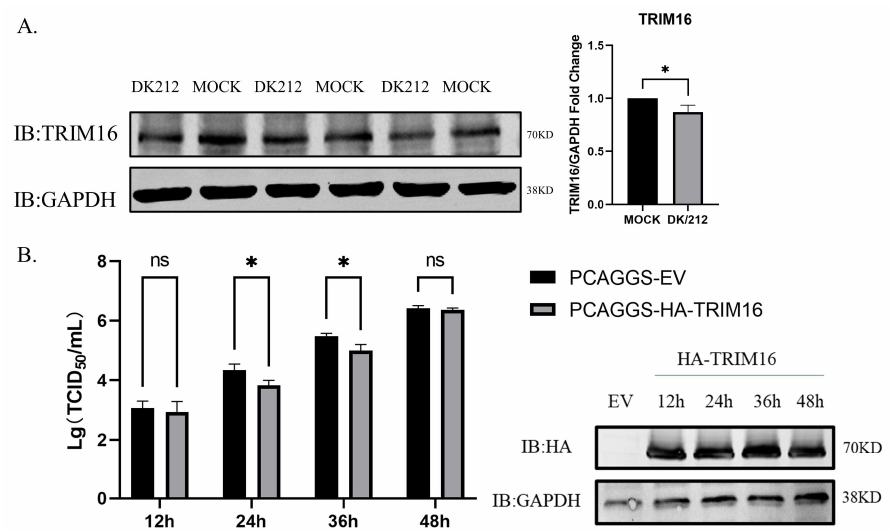
Figure 3. Overexpression of HA-TRIM16 reduces the titer of DK/212 virus in A549 cells. ( A ) Avian influenza virus infection reduces TRIM16 expression. Western blot analysis of TRIM16 protein expression in A549 cells infected with DK/212 virus for 24 h. GAPDH was used as loading control. ( B ) A549 cells were transfected with PCAGGS empty vector or PCAGGS-HA-TRIM16. At 24 h post transfection, the cells were infected with DK/212 at a dose of 0.1 MOI. The culture supernatants were harvested for viral titration at 12, 24, 36, and 48 hpi, respectively. All data were expressed as means ± SD, the Student’s t -test was used to analyze the differences (* p < 0.05).